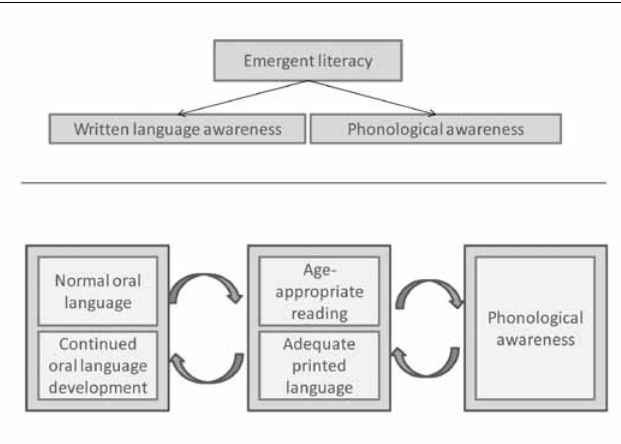
Fig. 1. The link between language and literacy